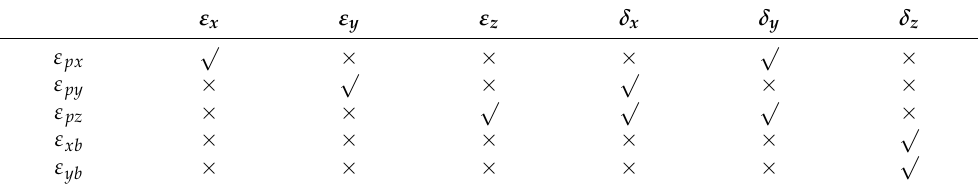
Table 1. The effects of the polyhedral prism’s manufacturing errors on the measurement of the six DOF motion